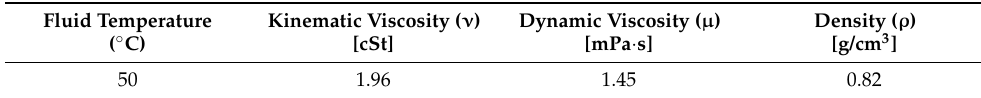
Table 2. Diesel properties at temperature of 50 °C.